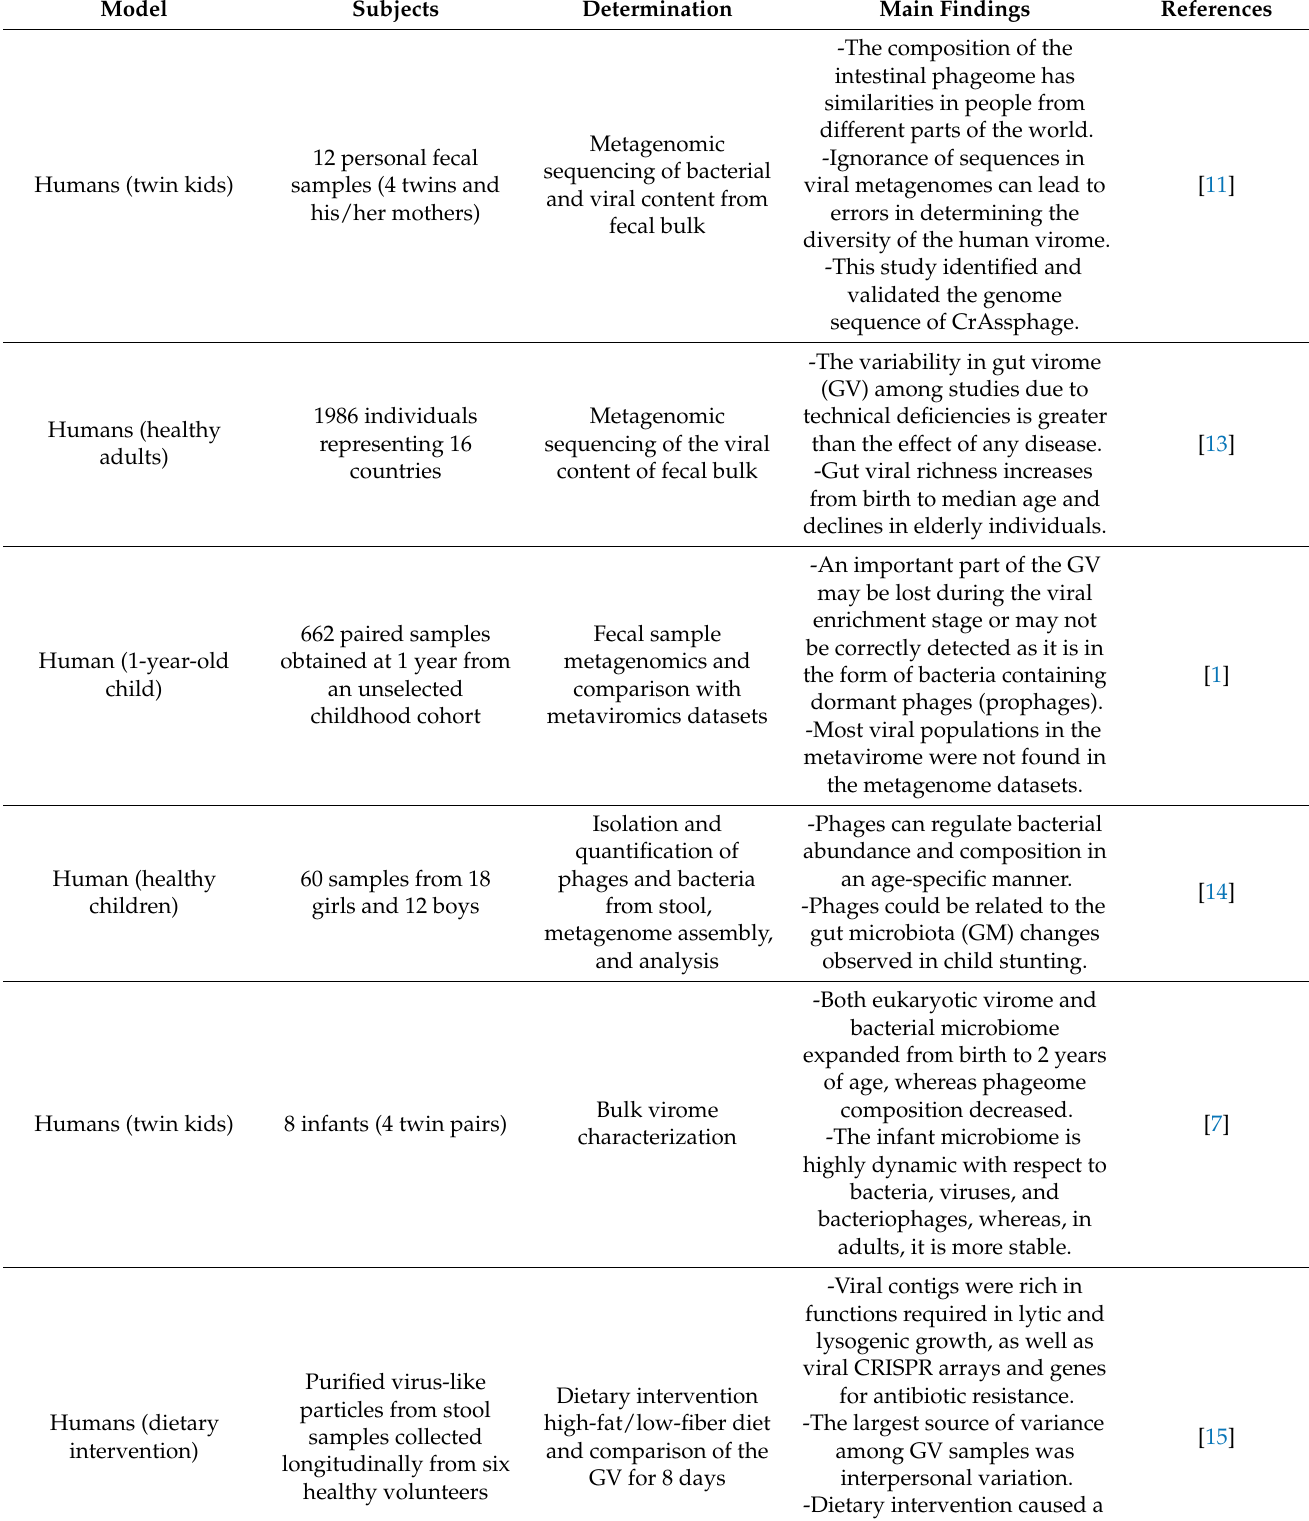
Table 1. Research works on the metagenomic analysis of the human